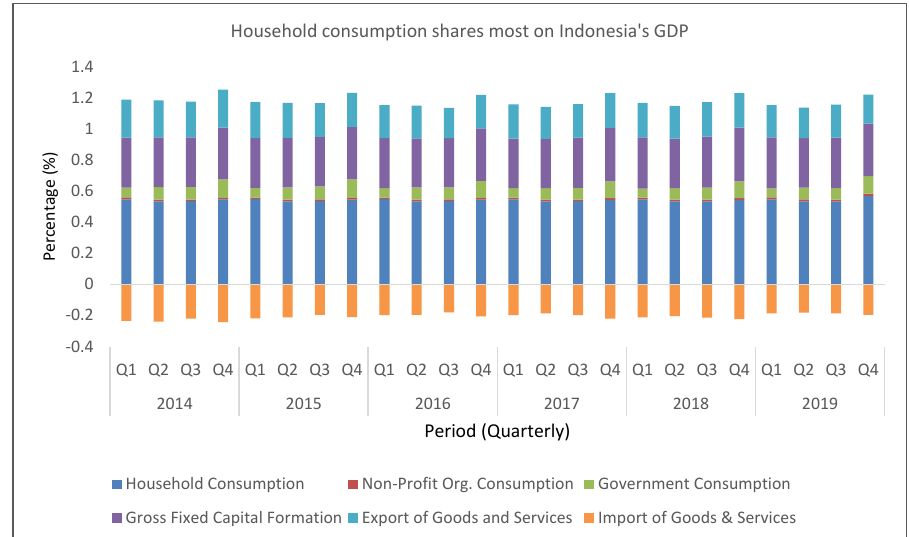
Fig. 3: Share to GDP by expenditure accounts (in decimals) (BPS, 2020)